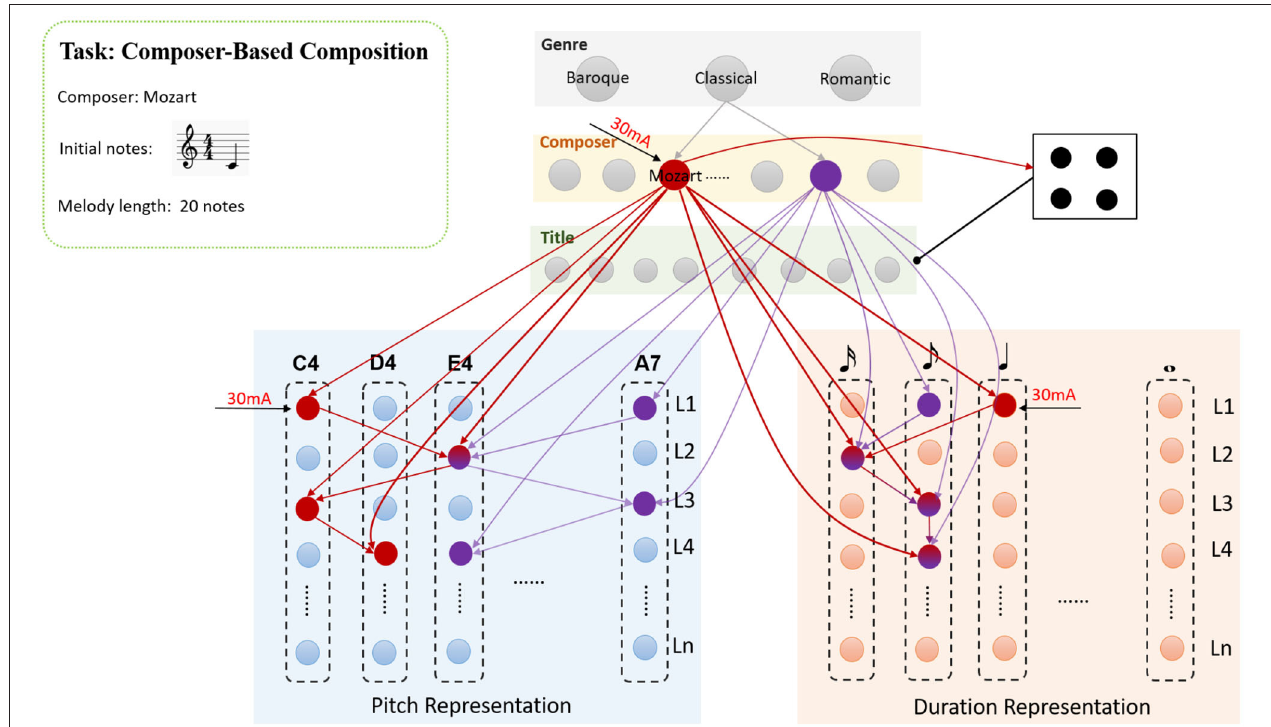
FIGURE 10 | The process of the composer-based composition, a melody with Mozart’s style is required to generate based on the composer cluster-interneurons-memory system circuits.